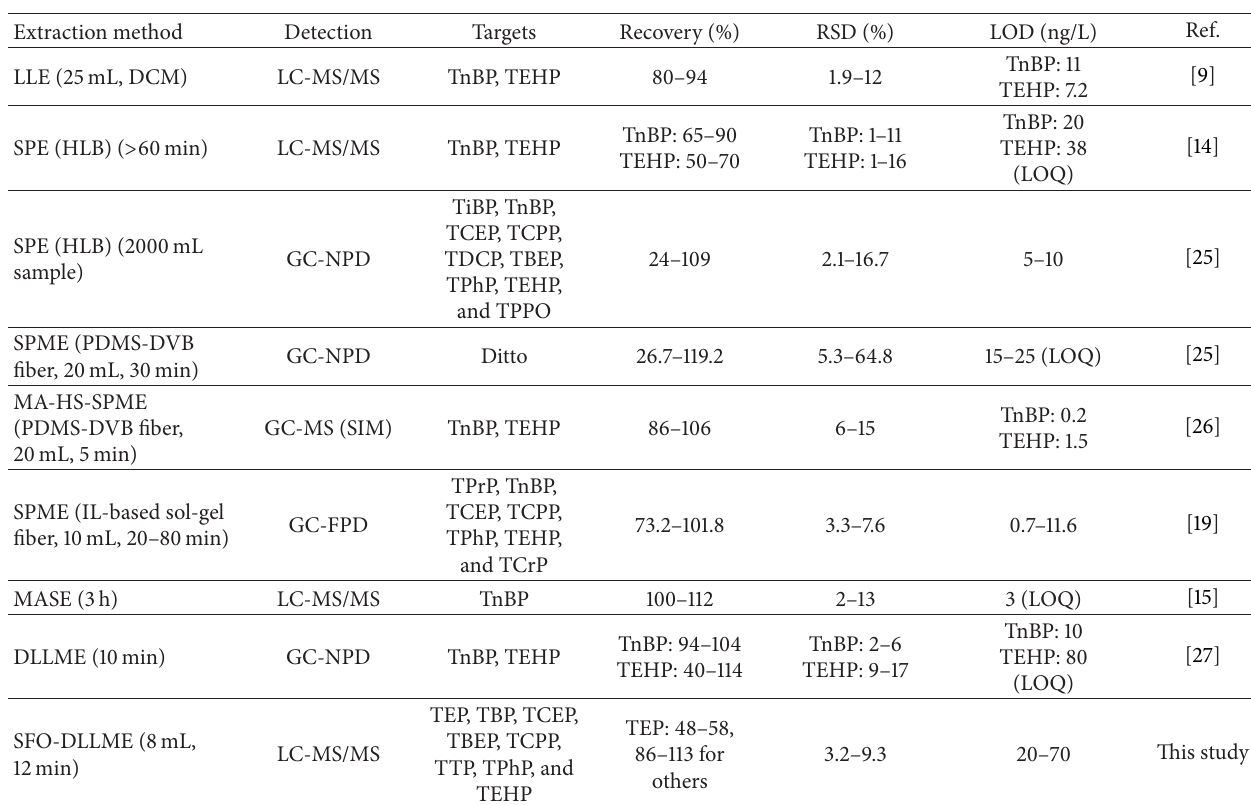
Table 4: Extraction effects for OPEs of different